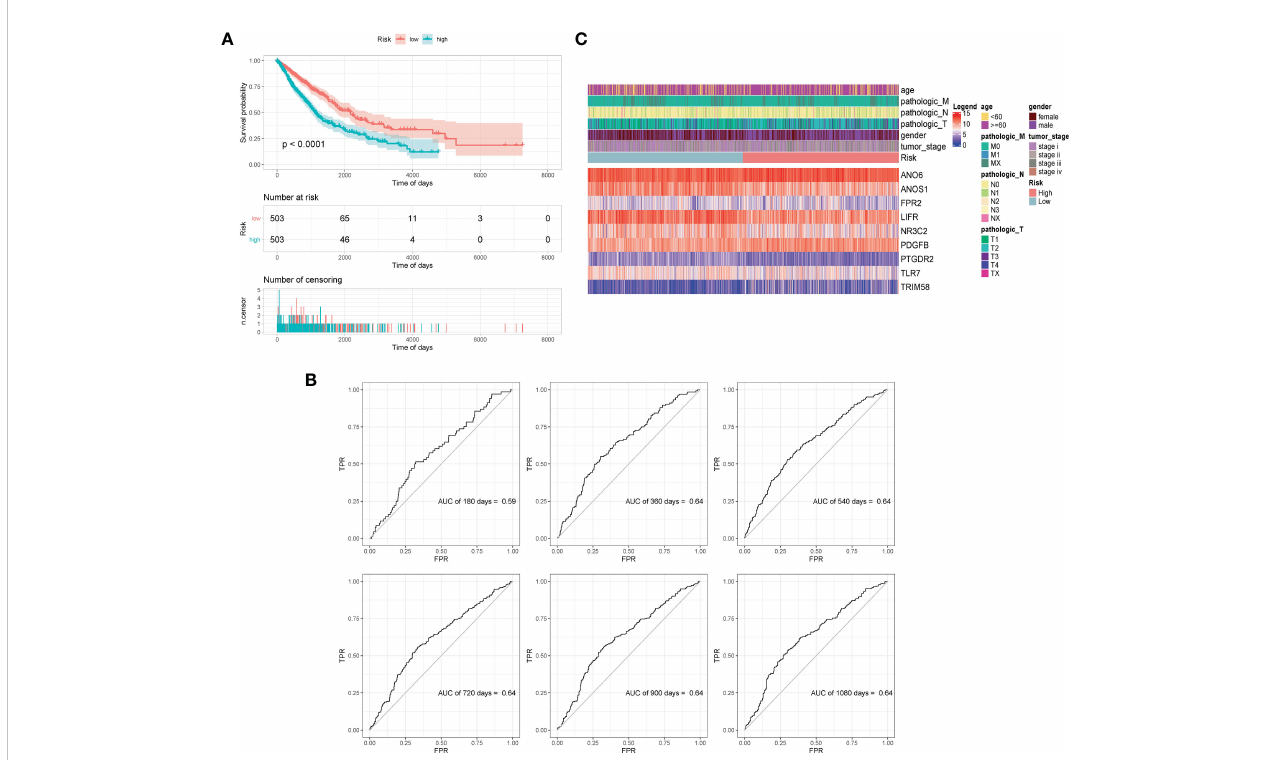
FIGURE 5 Validation of model effectiveness. (A) KM curves of high- and low-risk scores. (B) The AUC value of 180d, 360d, 540d, 720d, 900d, and 1080d by ROC curves. (C) Heatmap of gene expression in